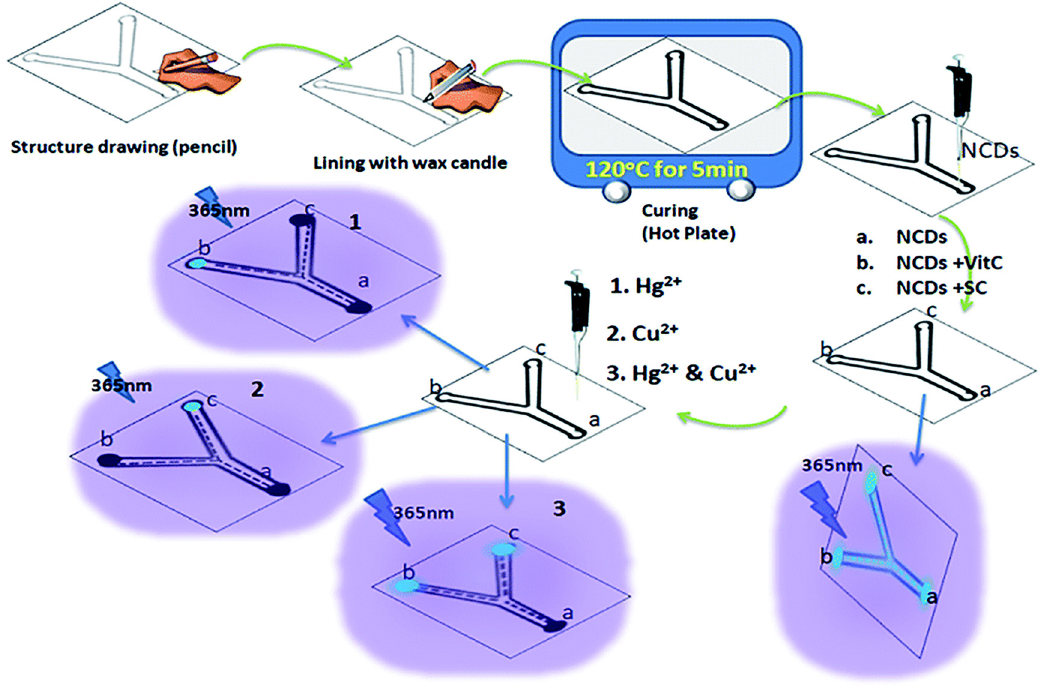
Figure 7: Schematic illustration of filter paper – based microfluidic device to parallel detect multiple metal ions of Hg(II) and Cu(II) ions. Reprinted from Zhao et al. ’ s work with the kind permission of The Royal Society of Chemistry [108]. Copyright (2019) The Royal Society of